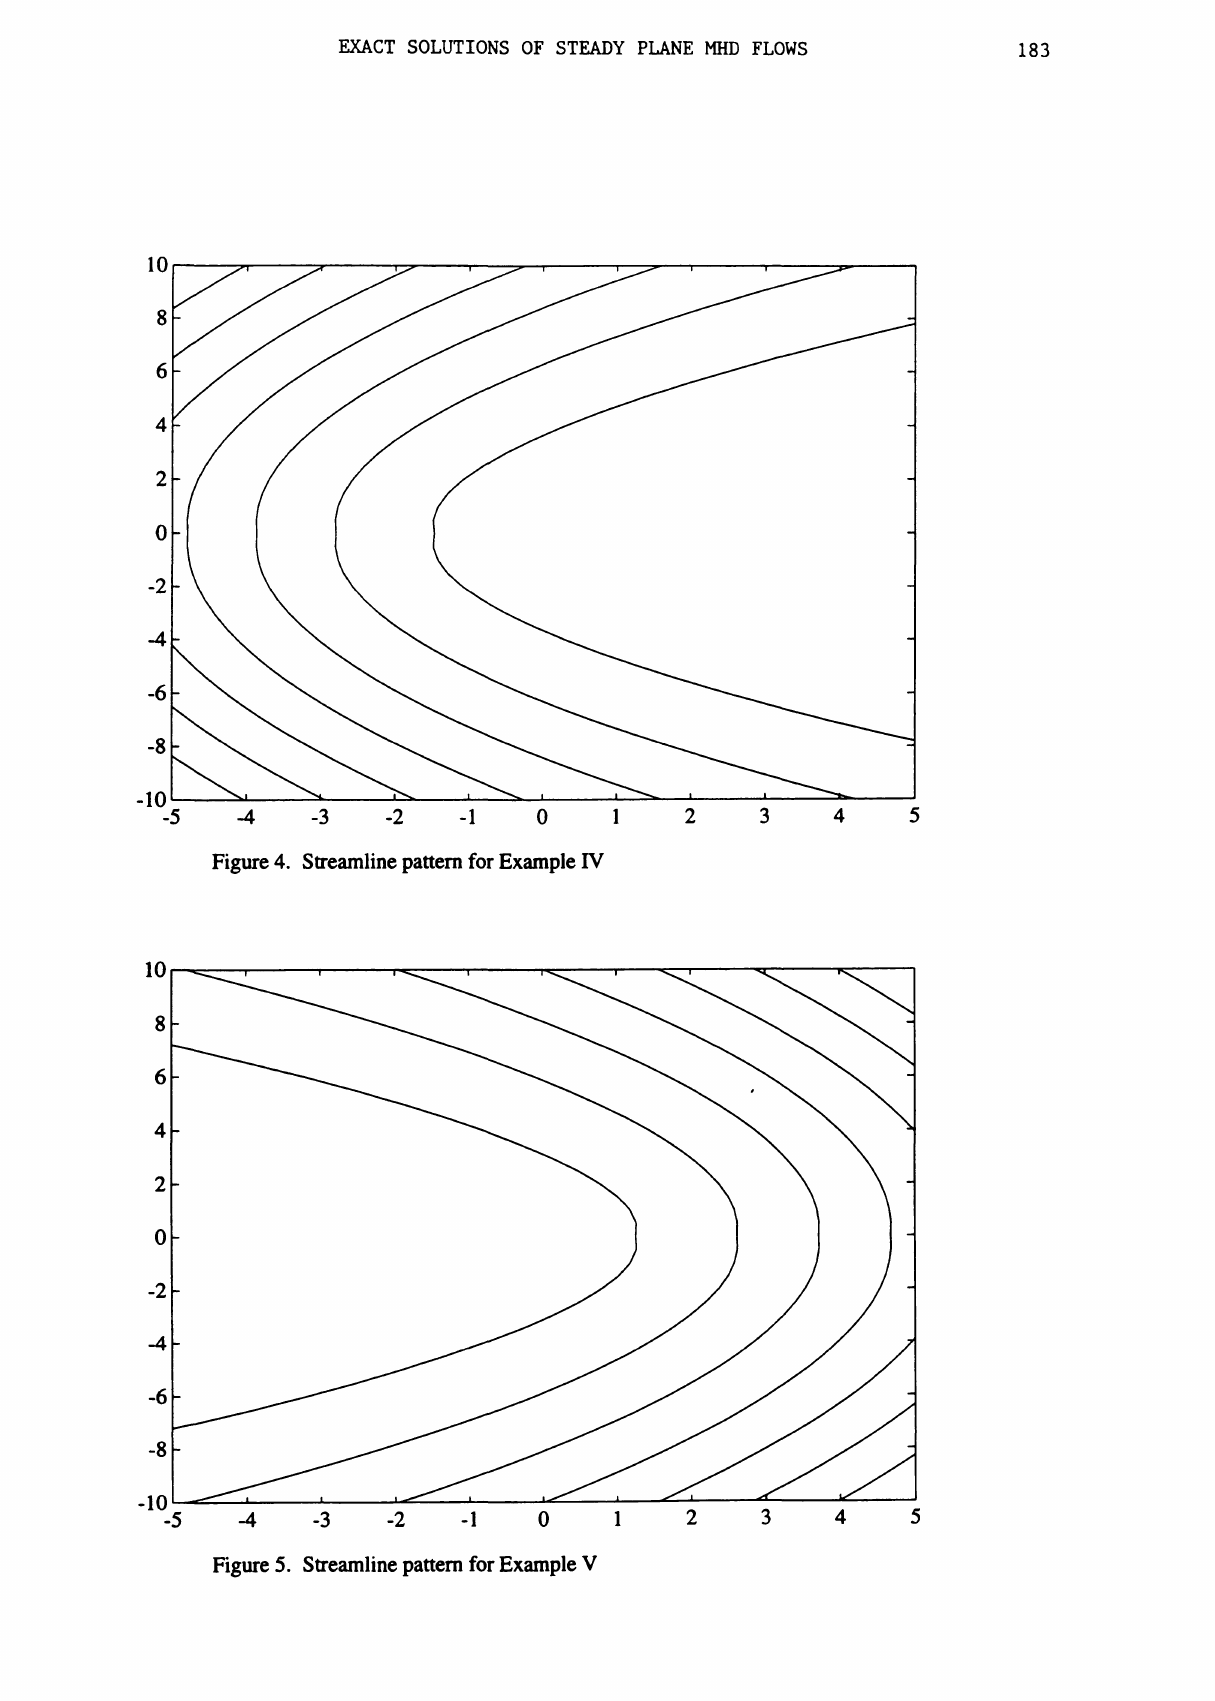
Figure 5. Streamline pattern for Example